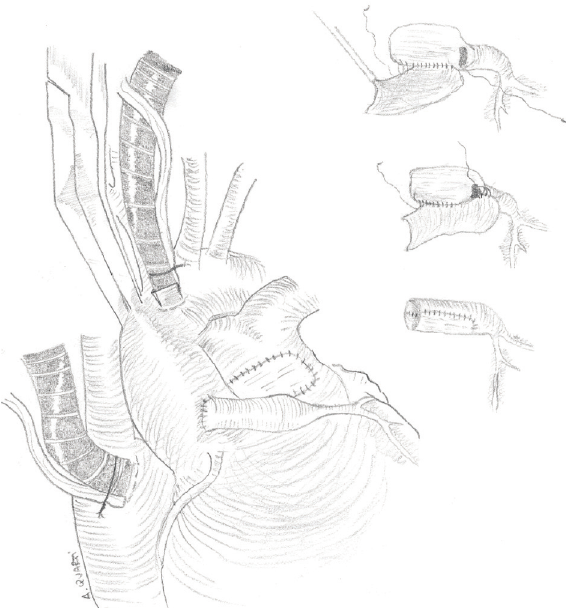
Figure 2: Creation and relocation of the